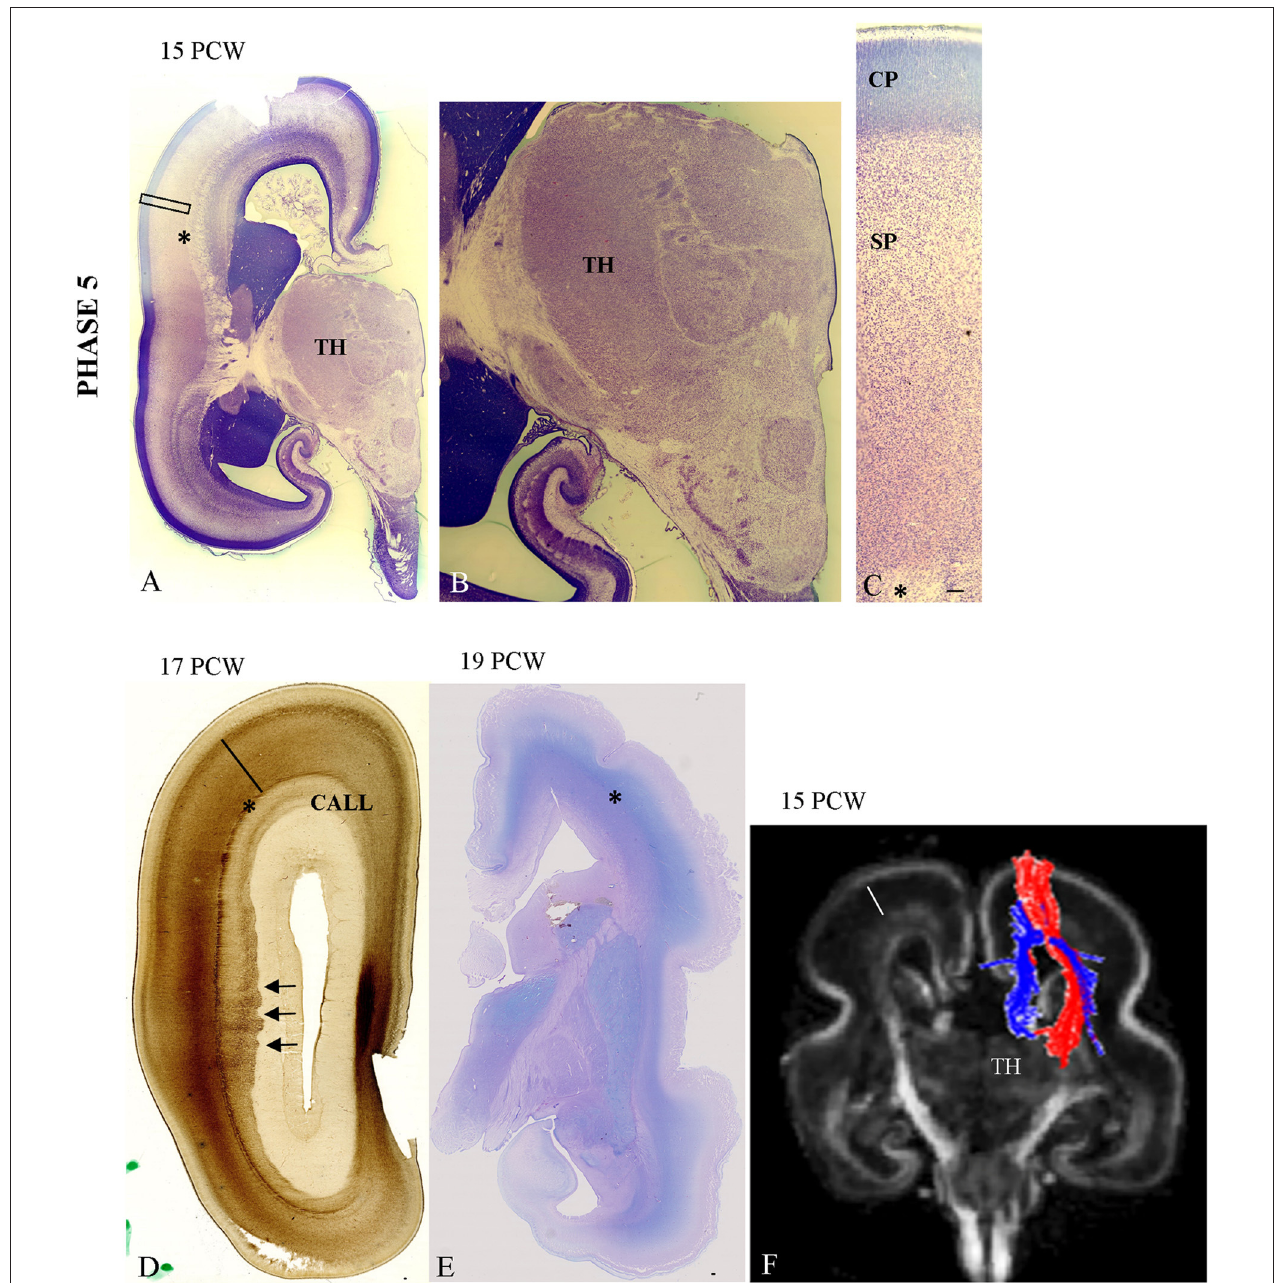
FIGURE 5 | The cytoarchitectonic differentiation of the VPL nuclei at 15 PCW (A,B) and further cytoarchitectonic differentiation of CP and SP ( C —Nissl stained section). The vertically aligned embryonic “columns” and cell-sparse SP with cells showing advanced cytological maturation (C) . Close interdigitation appears between callosal (AChE negative) and thalamic (AChE reactive) fibers ( D , arrows). (E) Periodic acid-Schiff (PAS)-Alcian staining at 19 PCW (compartment between asterisk and poorly-stained CP is SP). Asterisk marks border between SP and intermediate zone. (F) Shows DTI reconstruction of interdigitation of TH-C (red) and callosal fibers (blue) at 15 PCW. Scale bar: 100 µ